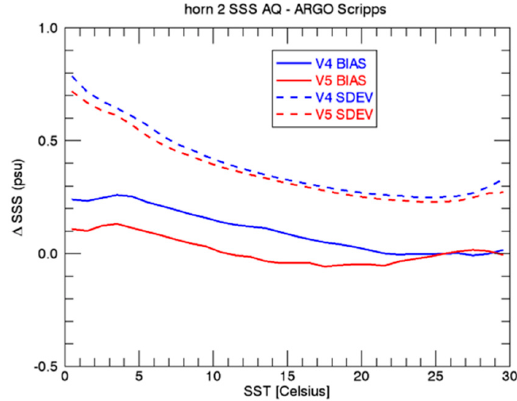
Figure 15. Difference between L2 Aquarius horn 2 and Scripps ARGO salinity as function of SST. The blue curves are for the Version 4 release. The red curves are for the Version 5 release. Full lines show the biases and dashed lines show the standard deviations. For the comparison observations containing rain have been discarded (see Section 2.2.6).